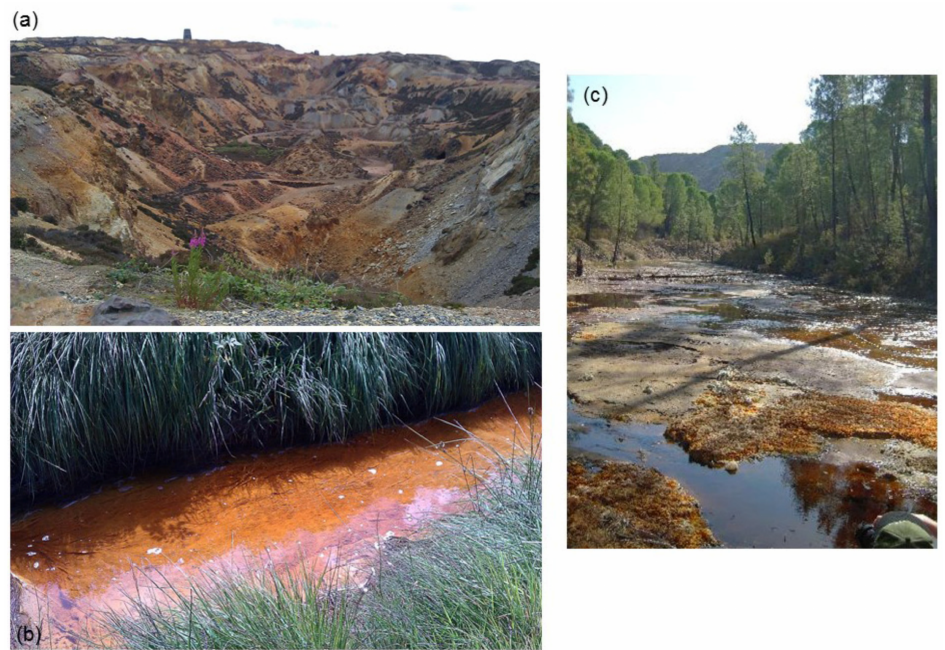
Figure 6. Examples of “natural biomines”: ( a ) the abandoned opencast operation and ( b ) the Afon Goch draining the former Mynydd Parys mine in north-west Wales; ( c ) the Rio Tintillo in south-west Spain, the catchment of waters percolating through a vast area of abandoned mine waste (shown in the back of the image).